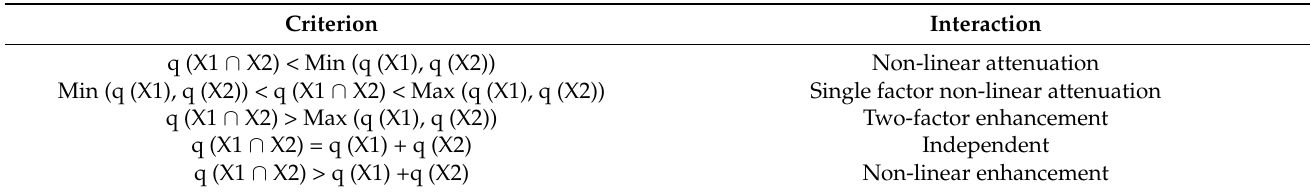
Table 2. Types of two-factor interaction result.